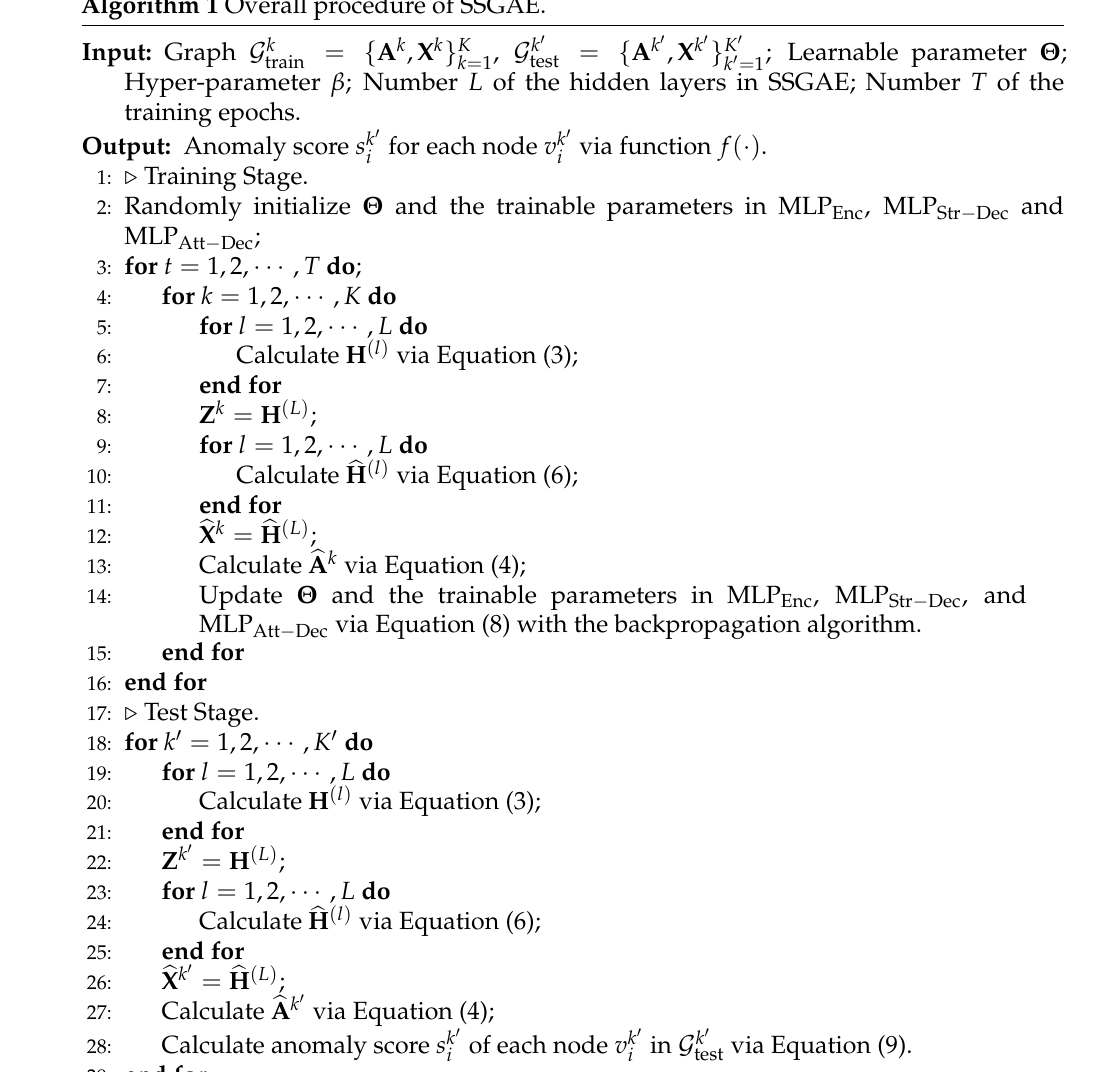
Algorithm 1 Overall procedure of